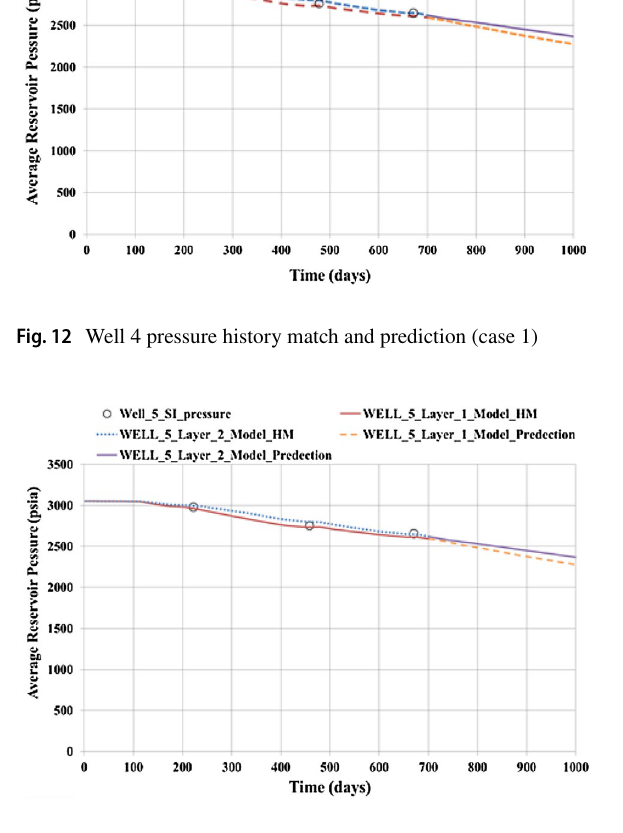
Fig. 13 Well 5 pressure history match and prediction (case